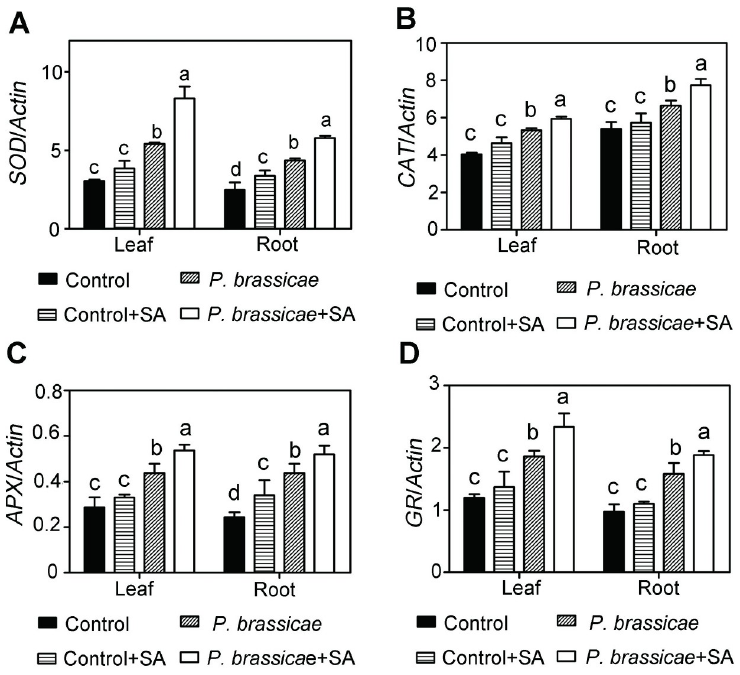
Fig 4. Relative gene expression levels in roots and leaves. SOD (A) , CAT (B) , APX (C) , and GR (D) expression levels in different groups were detected. The data shown represent the average ± SD (n = 3). Different letters represent significance (Tukey’S HSD test, P <